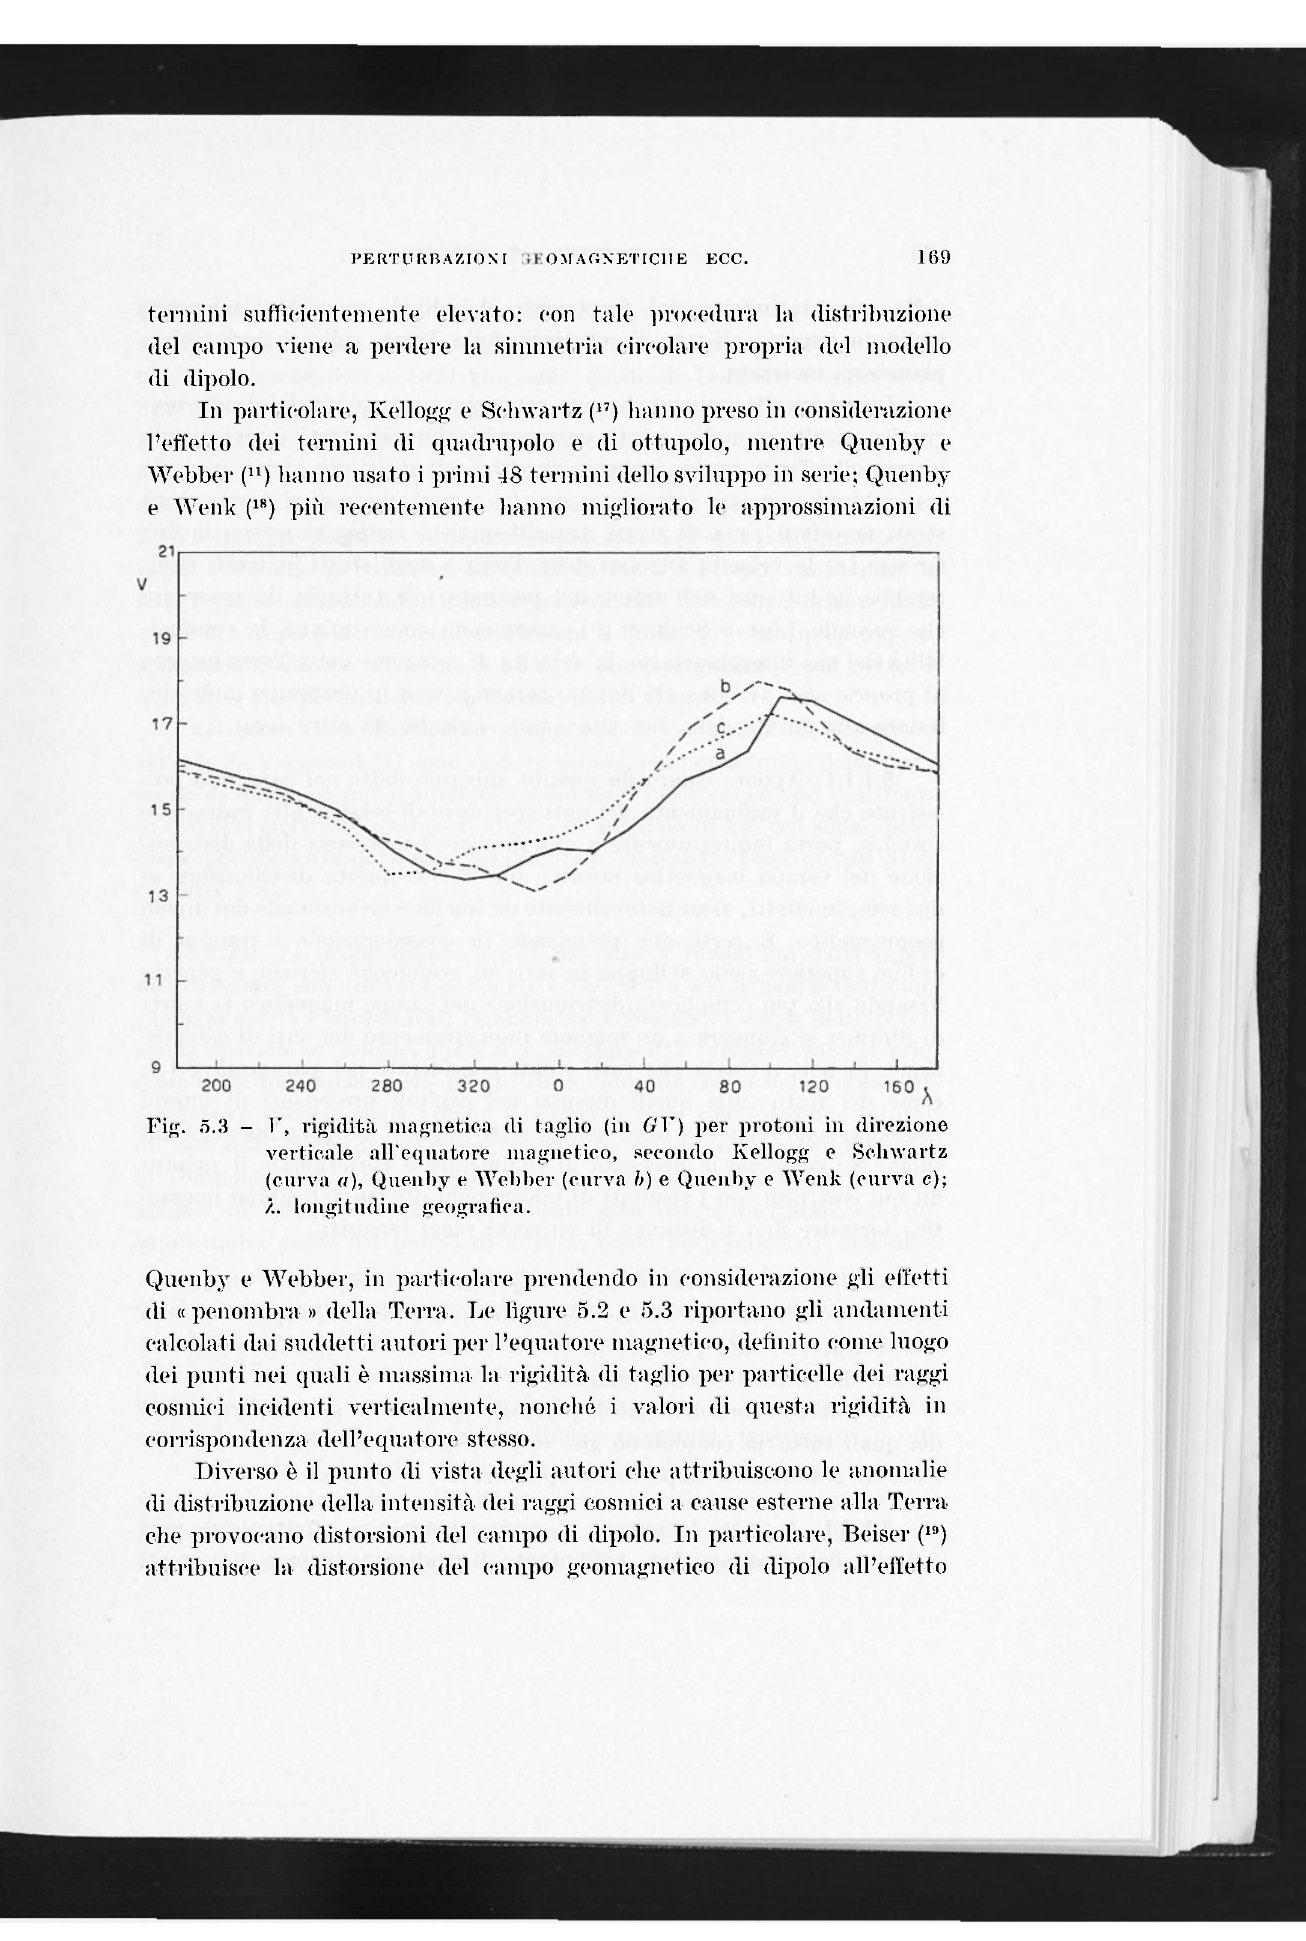
Fig. 5.3 1", rigidità magnetica di taglio (in GÌ") per protoni in direzione verticale all'equatore magnetico, secondo Kellogg e Schwartz (curva a), Quenby e Webber (curva b) e Quenby e Wenk (curva c); A, longitudine